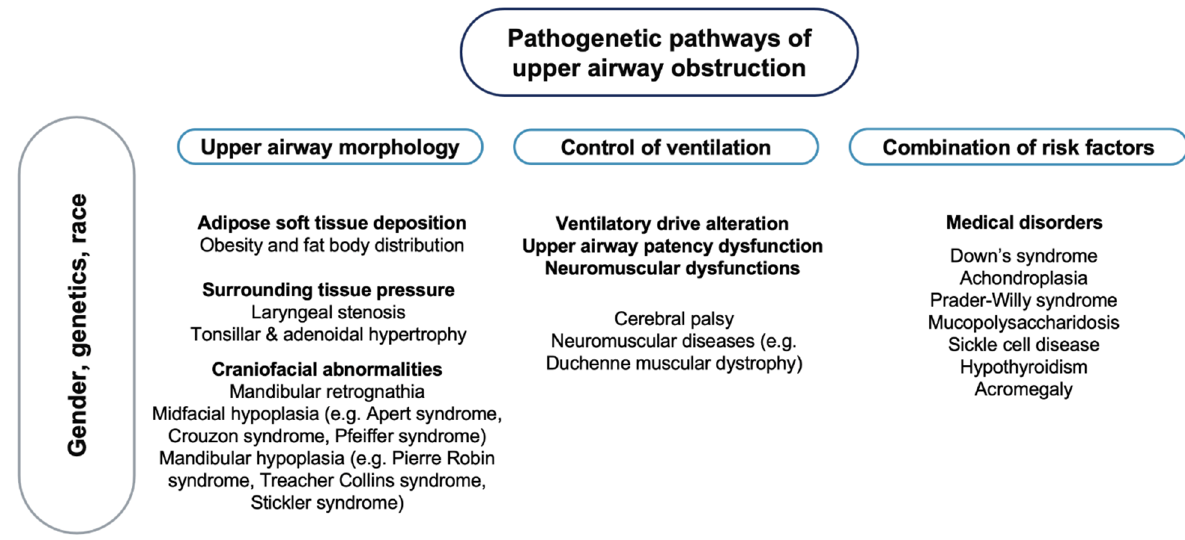
Figure 1. Pathogenetic pathways of upper airway obstruction. Note: On a background influenced by gender, genetics and race, different pathogenetic factors may lead to upper airway obstruction.